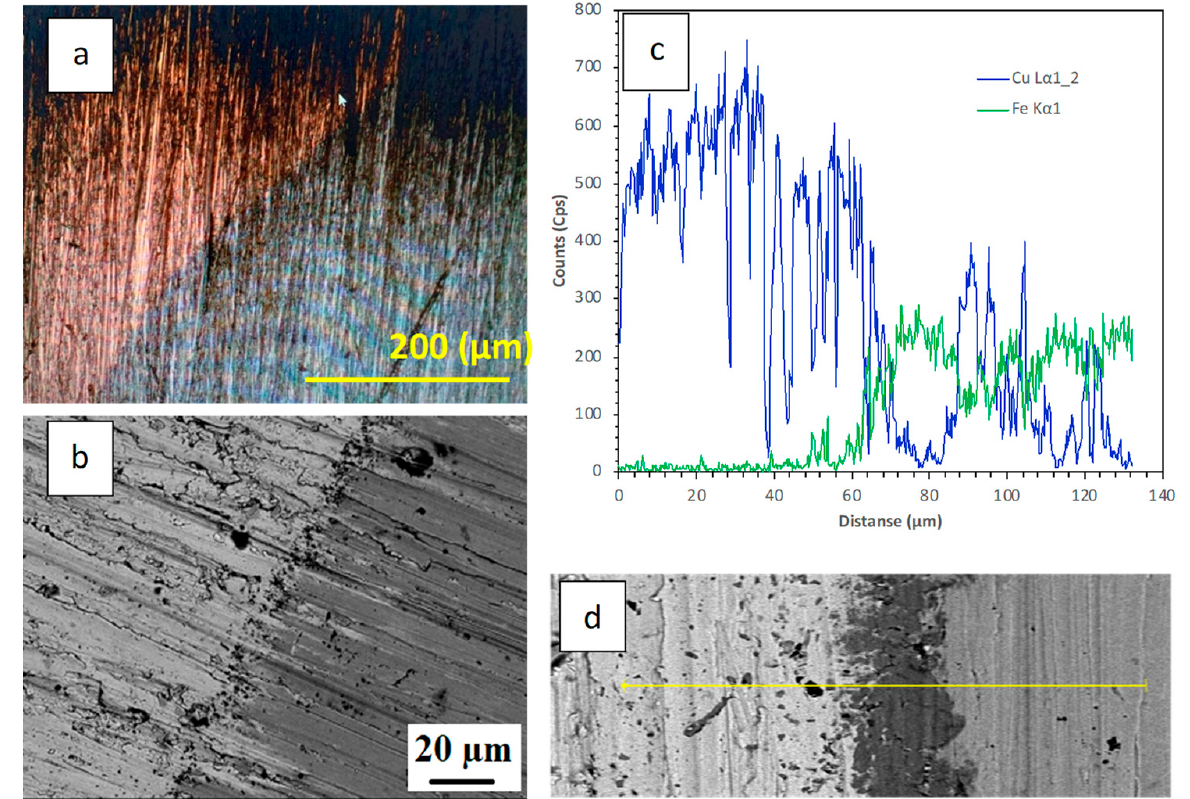
Figure 4. ( a ) Light microscopy image; ( b ) SEM image of a QMMC prepared by pouring molten copper onto a steel rod at room temperature; ( c ) and ( d ) an EDS spectrum collected from the in- terface region and corresponding high magnification SEM image.